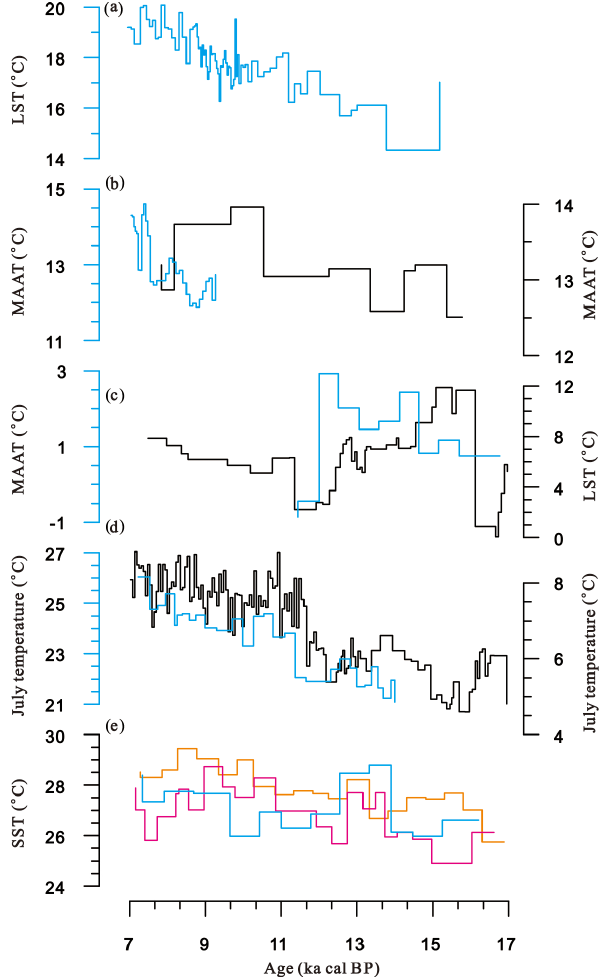
Figure 6. A comparison of TEX 86 -based lake surface temperature of Lake Chenghai (a) with other paleotemperature records from the ISM region. (b) Mean annual temperature based on branched GDGTs from Lake Ximenglongtan (blue line, Ning et al., 2019) and Lake Tengchongqinghai (black line, Tian et al., 2019); (c) alkenone- based mean annual temperature at Lake Dangxiong (blue line, Ling et al., 2017) and TEX 86 -based lake surface temperature of Nam Co from the southern Tibetan Plateau (black line, Günther et al., 2015); (d) July temperature reconstructed from pollen record from Lake Xingyun (blue line, Wu et al., 2018) and subfossil chironomids from Lake Tiancai (black line, Zhang et al., 2017a, 2019); and (e) SSTs in the Andaman Sea and Bay of Bengal (Rashid et al., 2007; Govil and Divakar Naidu, 2011; Gebregiorgis et al.,